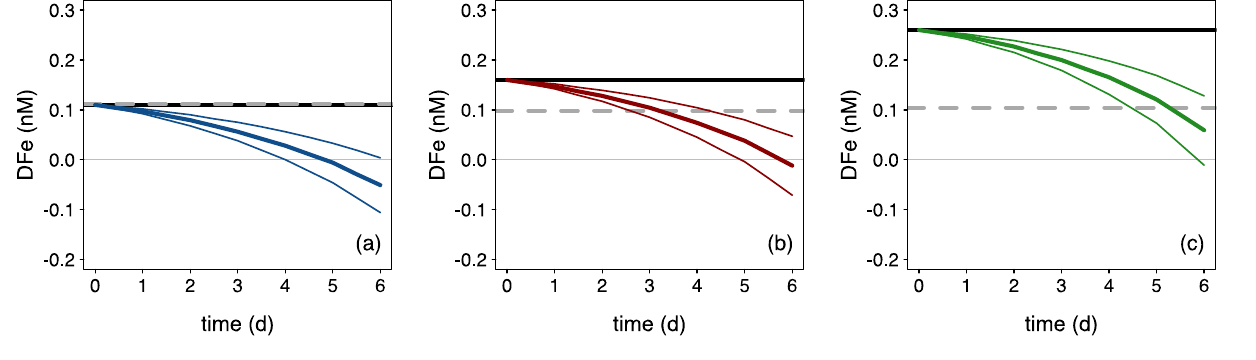
Figure 7. Theoretical evolution of DFe driven by phytoplankton uptake (colored curves) for the ( a ) Fe-NO, ( b ) Fe-NEW, and ( c ) Fe-REG treatments. Theoretical evolutions of DFe are represented by colored lines: blue, red and green for the Fe-NO, Fe-NEW and Fe-REG treatments, respectively, and were generated by combining the in situ size-fractionated Fe uptake rates (Supplementary Table S4) with the evolution of the pico-, nano- and microphytoplankton biomass obtained from a diagnostic pigment criteria (Section 2.2). Mean and standard deviations for the three biological replicates are shown in thick and thin colored lines, respectively. The black and grey-dotted lines are a linear interpolation between the measured initial and final DFe concentrations.